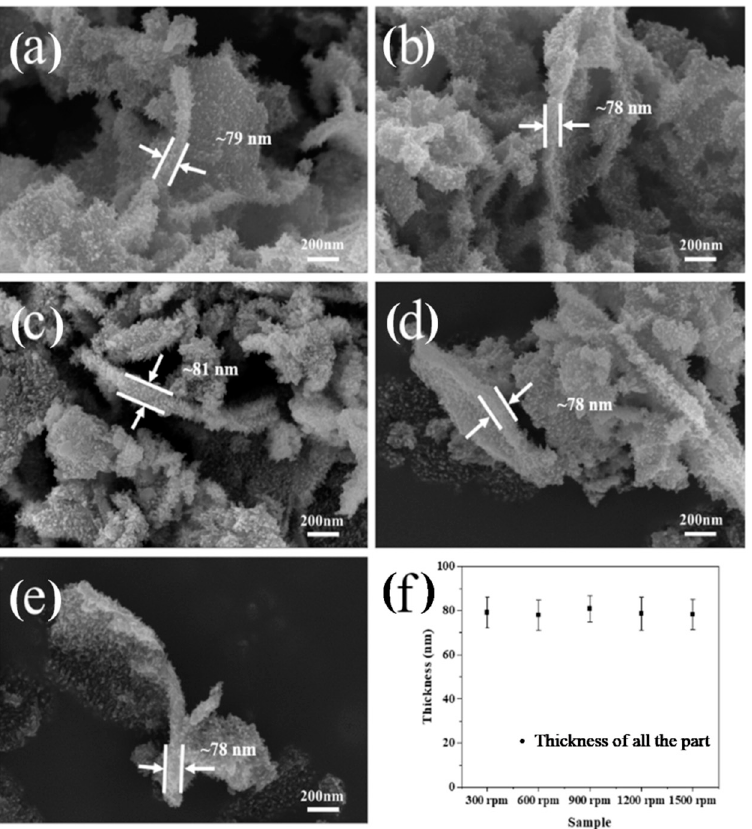
Figure 6. SEM images of the prepared samples with different stirring rates: ( a ) 300 rpm, ( b ) 600 rpm, ( c ) 900 rpm, ( d ) 1200 rpm and ( e ) 1500 rpm. ( f ) The thickness data of the samples.